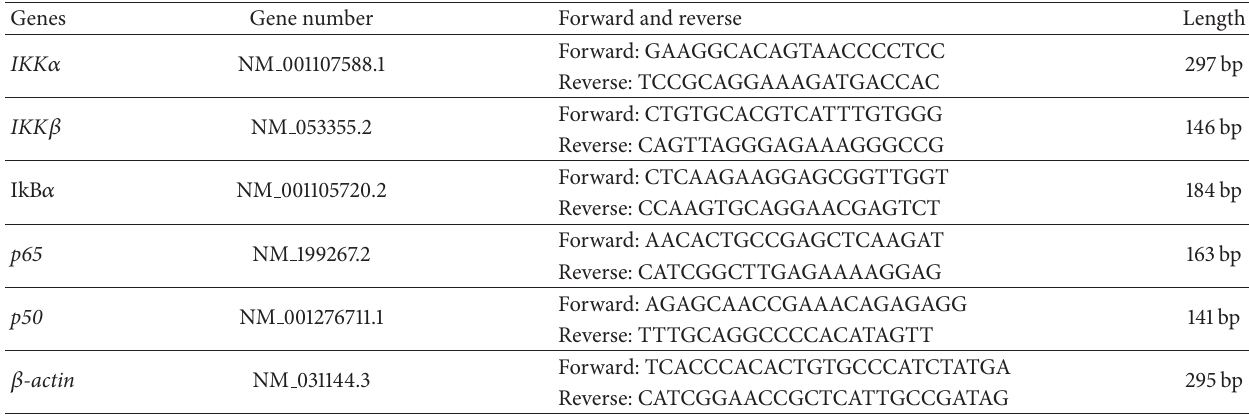
Table 1: The sense and antisense primers used for